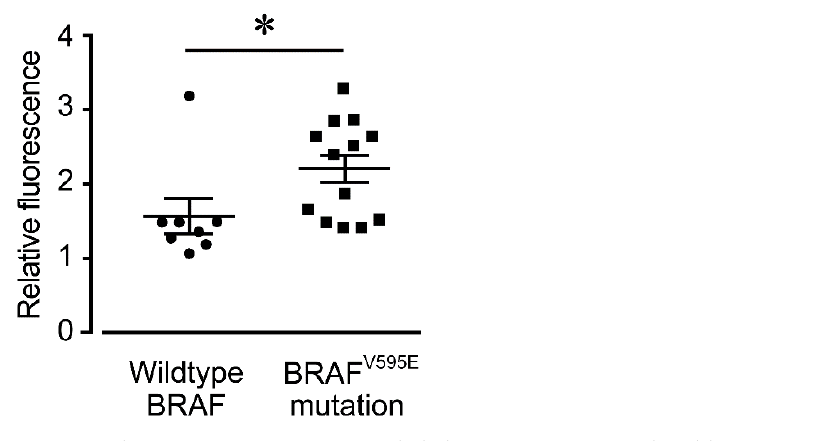
Figure 4. Fluorescence intensity in urothelial carcinoma cases with wild-type BRAF ( n = 8) and cases with the BRAF V595E mutation ( n = 13). Fluorescence intensity is expressed as a ratio of the amount of fluorescence in the 5-ALA supplemented group relative to the amount of fluorescence in the vehicle group for each sample. * p < 0.05. The horizontal lines indicate the mean ± SD.